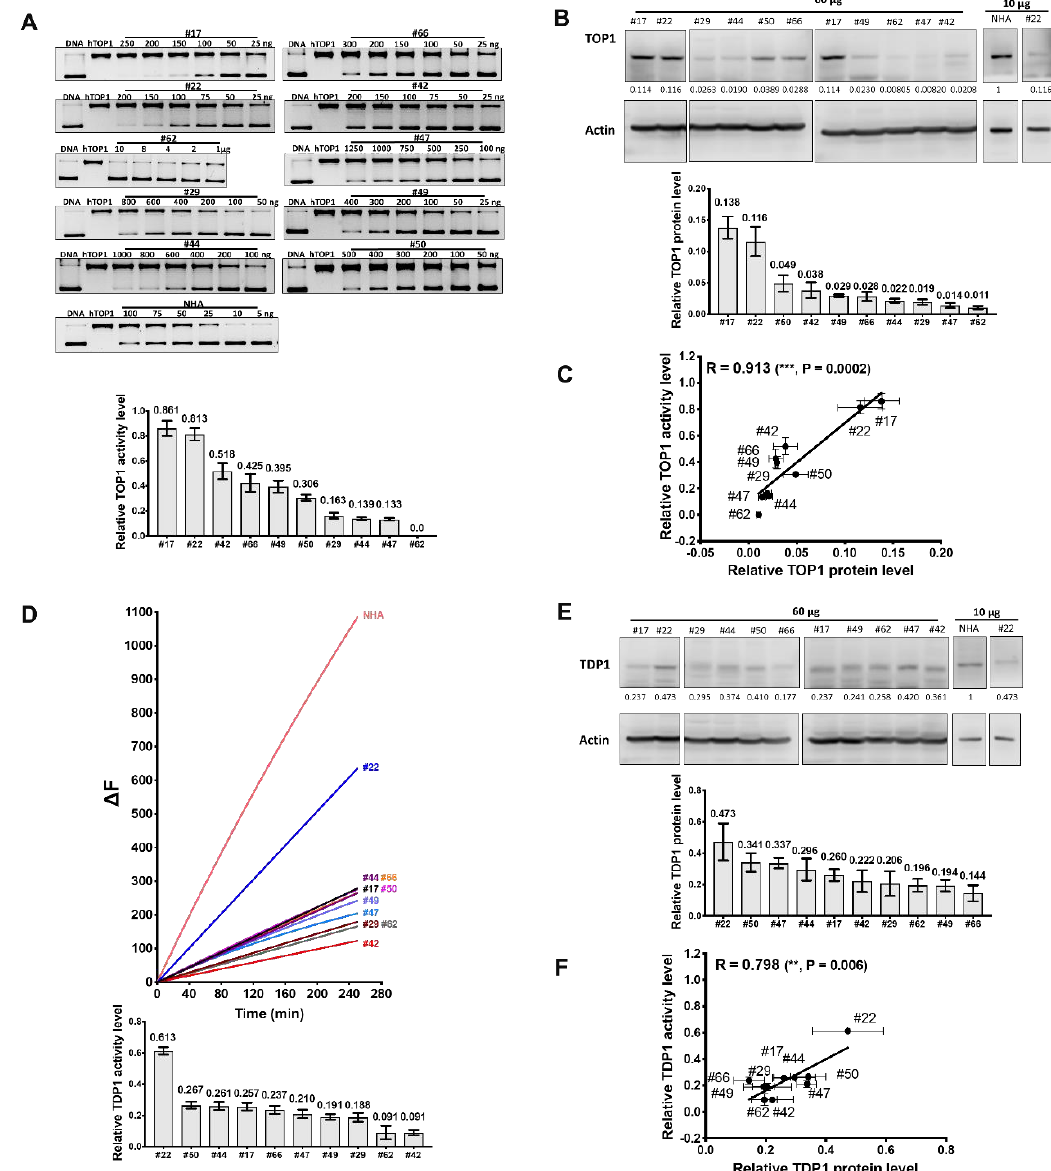
Figure 8. TOP1 and TDP1 activity and protein levels in GBM patient tumor WCEs. ( A ) Assay of TOP1 activity in GBM patient tumor WCEs; ( B ) Western blot analysis of TOP1 protein expression. The first two panels are from the same blot. Signal from actin was used to control loading of WCE proteins (60 µg). Normalized intensity ratios are given for each band, with the intensity ratio of NHA set as 1; ( C ) Pearson correlation of relative TOP1 protein and activity levels in GBM patient tumor WCEs; ( D ) fluorescence-based assay of TDP1 activity; ( E ) Western blot analysis of TDP1 protein expression; ( F ) Pearson correlation of relative TDP1 protein and activity levels in GBM patient tumor WCEs. The bar graphs (n = 3 or more) show the average and standard deviation as error bars for relative TOP1 and TDP1 activity or protein levels normalized against activity and protein expression in NHA. Whole blots with molecular weight markers are shown in Figure S7.